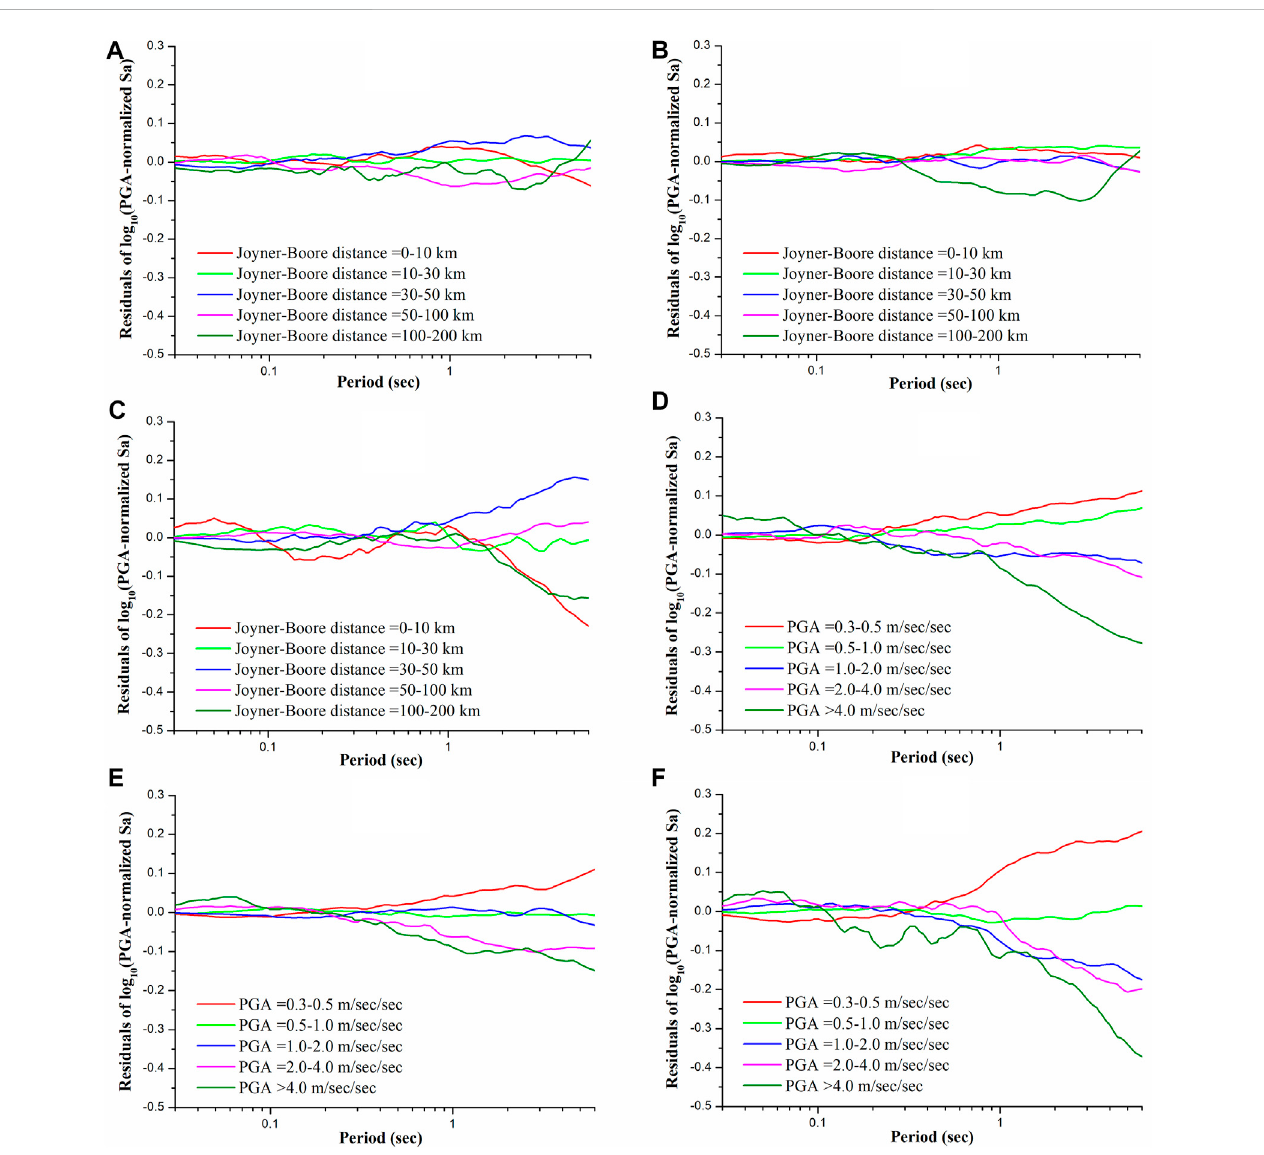
FIGURE 5 ResidualsoflogarithmicPGA-normalizedSawithdifferentJoyner-Booredistanceintervalson (A) siteclassI, (B) siteclassII, (C) siteclassIII,andresiduals of logarithmic PGA-normalized Sa with different PGA intervals on (D) site class I, (E) site class II, and (F) site class III.